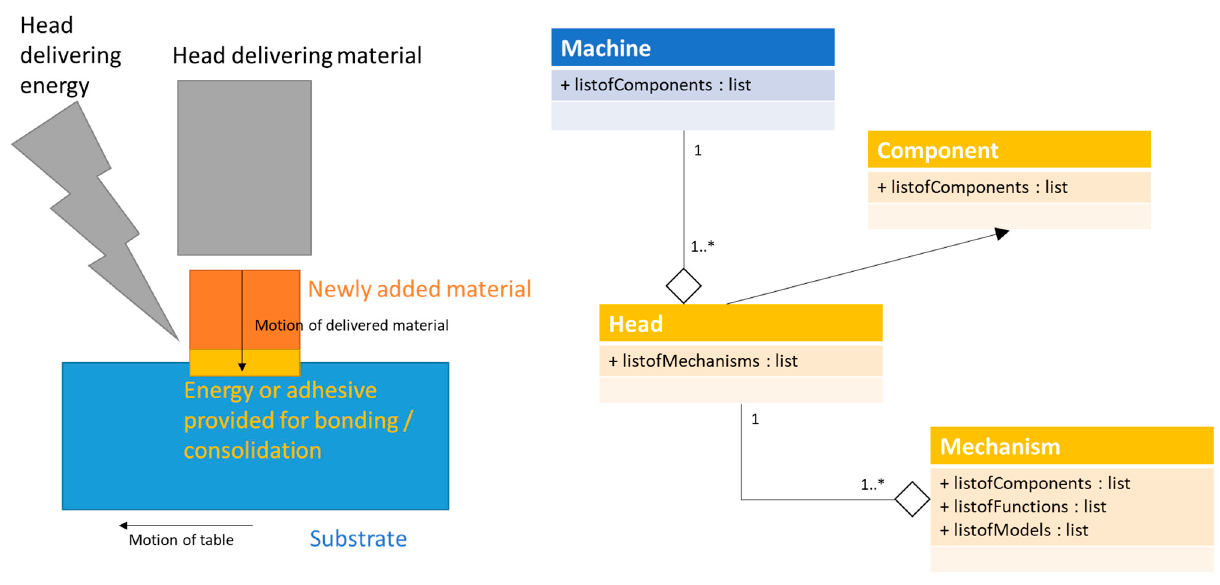
Figure 2. Abstract depiction of AM machine modules ( left ) and the corresponding abstract modelling using unified modeling language (UML) ( right ).